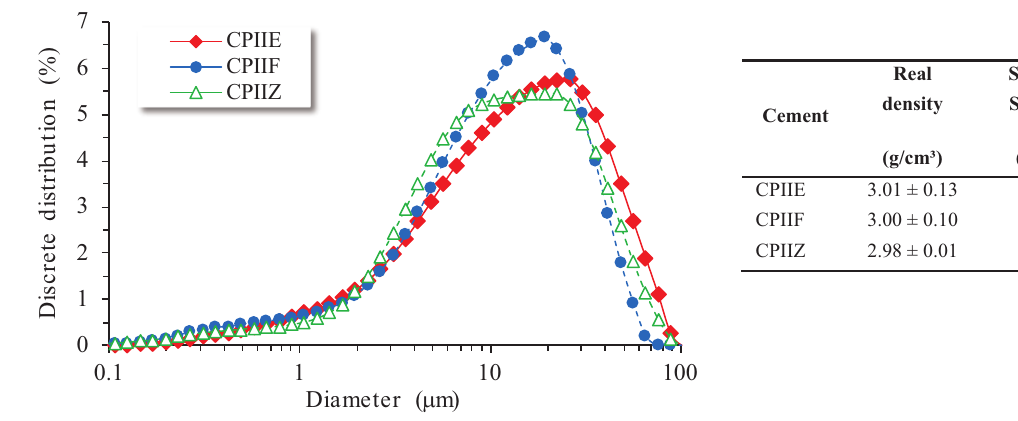
Particle size distribution, real density and specific surface area of Portland